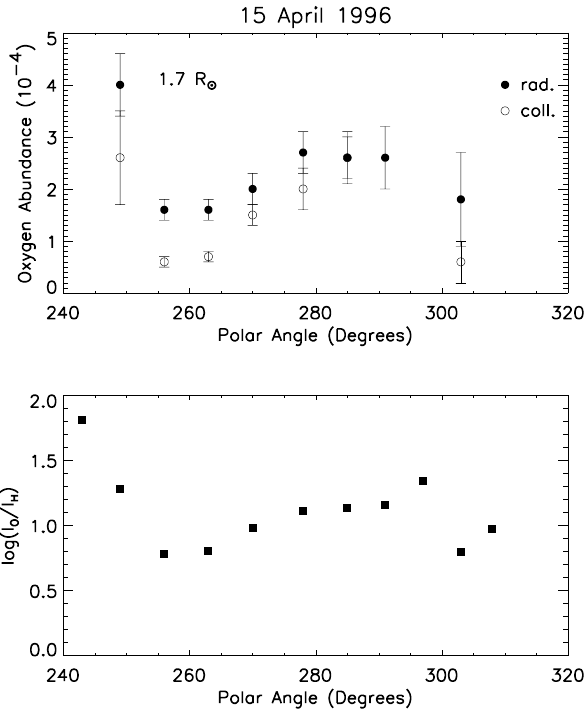
Fig. 2. Top panel: oxygen abundance relative to hydrogen deter- mined at 1.7 R (cid:12) approximately across the axis of the equatorial coronal streamer observed at the West limb on 15 April 1996 (polar angle 270 ◦ corresponds to the equator at the West limb). Bottom panel: relative intensity of the O VI 1032 to the H I Ly β line mea- sured at 1.7 R (cid:12) on 15 April